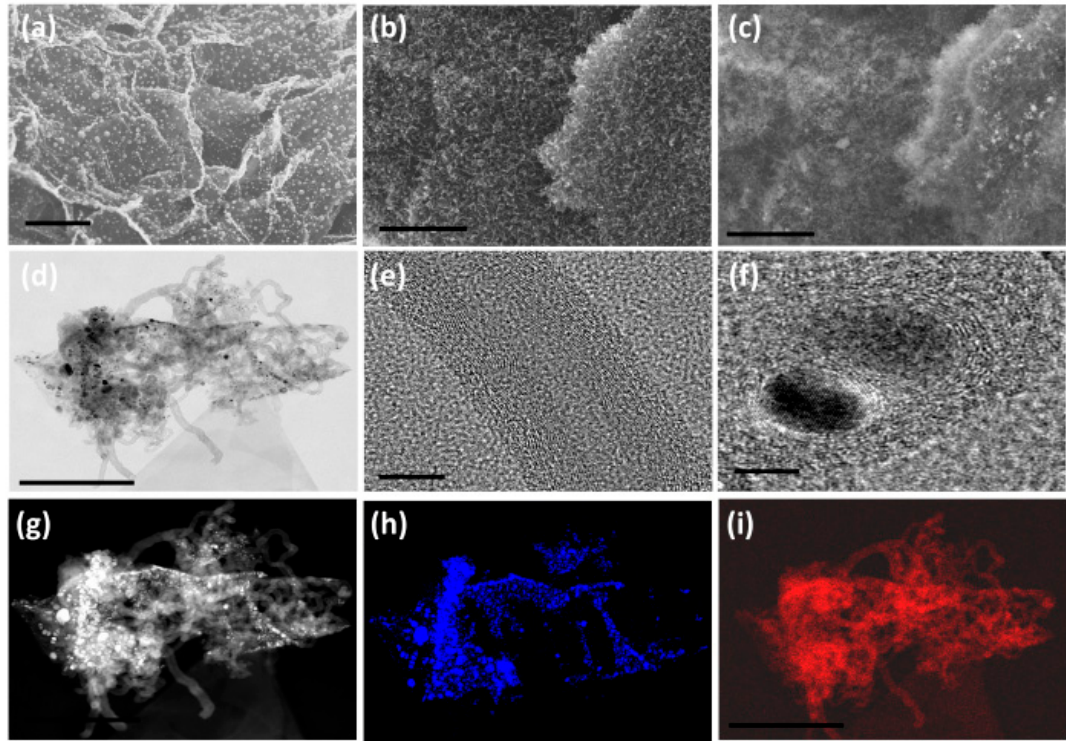
Figure 1. In-lens SEM micrographs ( a , b ) of Mn-H 3 BTC decorated graphene oxide and MnO 2 @CNT-rGO synthesized from the same by microwave synthesis and its corresponding secondary electron image ( c ). High-resolution transmission electron microscopic (HRTEM) image of MnO 2 @CNT-rGO ( d ) and high magnification image of defect rich individual carbon nanotubes ( e ) and MnO 2 nanoparticle ( f ); high-angle annular dark-field (HAADF) image ( g ) and its corresponding manganese ( h ) and carbon map ( i ). Scale bars are 1 µm in ( a – c ); 500 nm in ( d ); 50 nm ( e ); 20 nm ( f ); and 500 nm in ( g – i ).